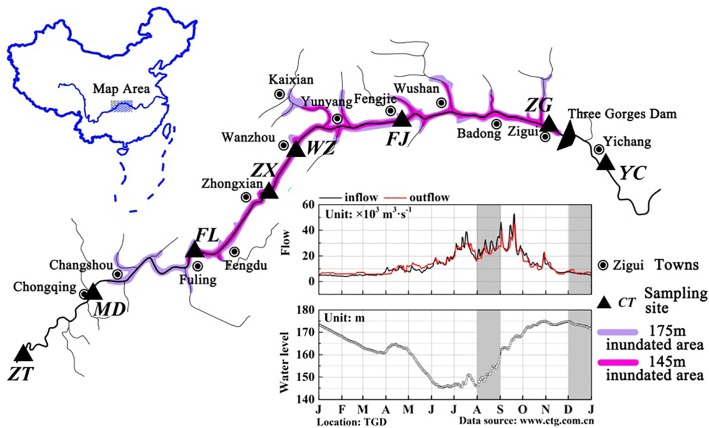
Maps of the TGR showing the location of the sampling sites. Base map of the Yangtze River systems in the TGR and map of China were created by Adobe Photoshop CS5. Sub-graph of daily variations of reservoir in- and outflows, as well as reservoir water levels in 2015, was generated by OriginLab 9.4. Data source was from the web site of the China Three Gorges Cooperation (http://www.ctg.com.cn/). Dark area indicated the time when the samples were taken.